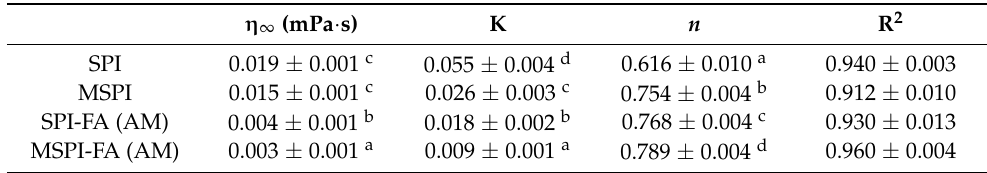
Table 2. The apparent viscosity ( η ), consistency index (K), and flow behavior index ( n ) of emulsions stabilized by different modified soybean protein